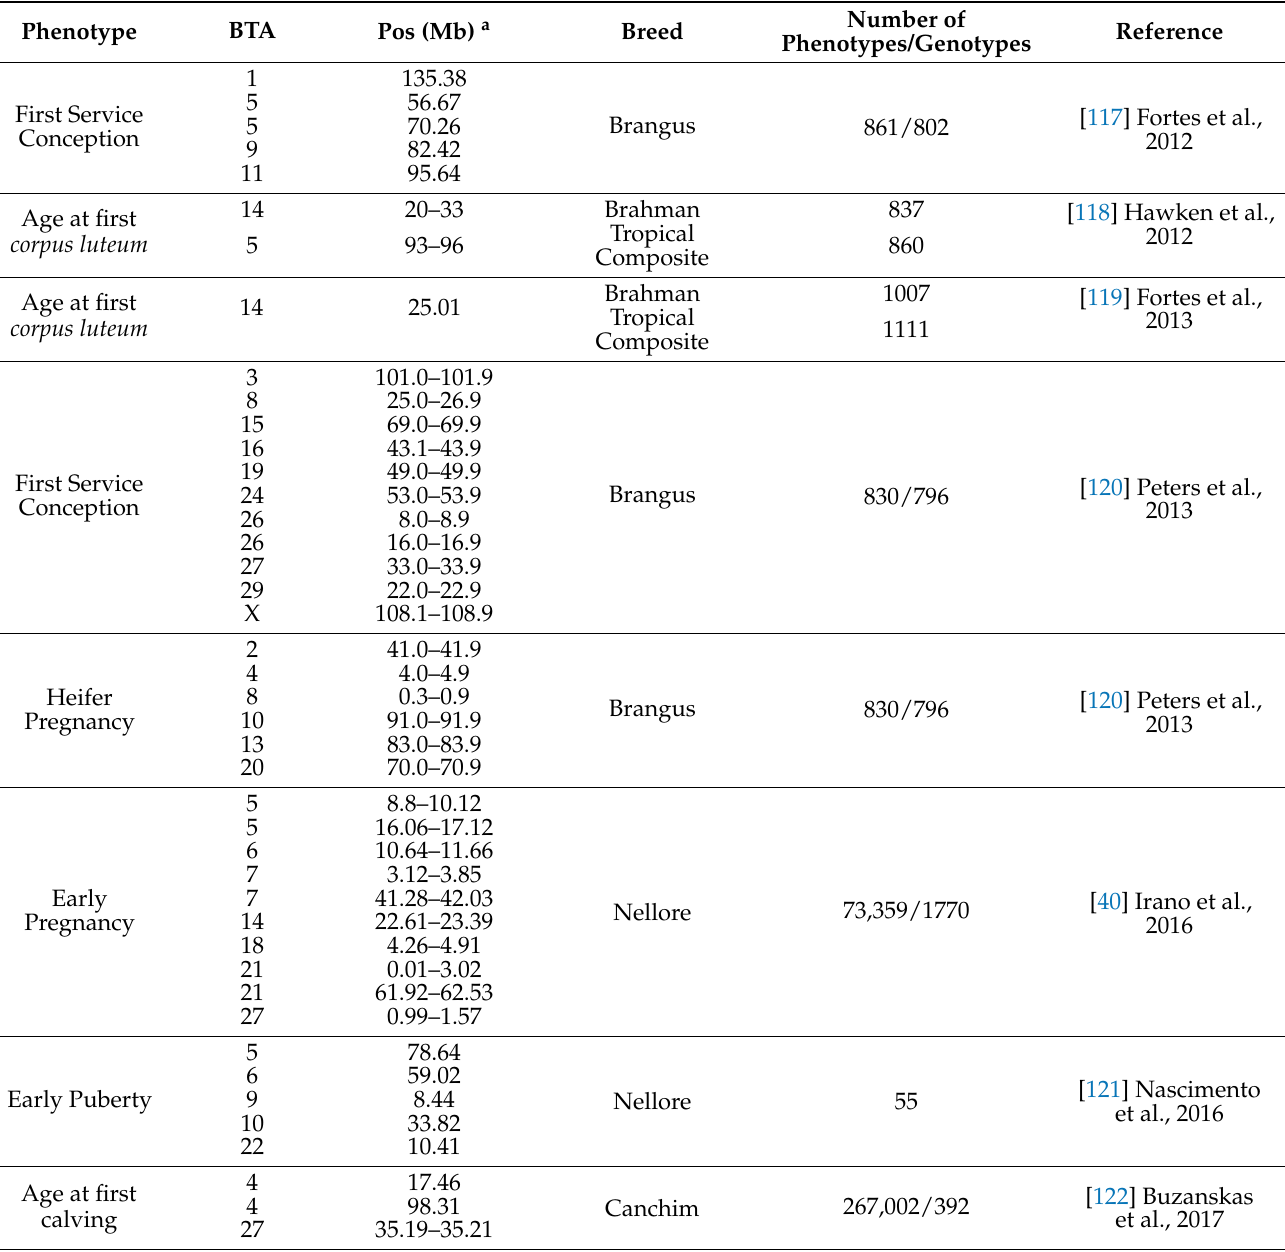
Table 1. Genomic regions associated with sexual precocity in Bos indicus and influenced Bos indicus